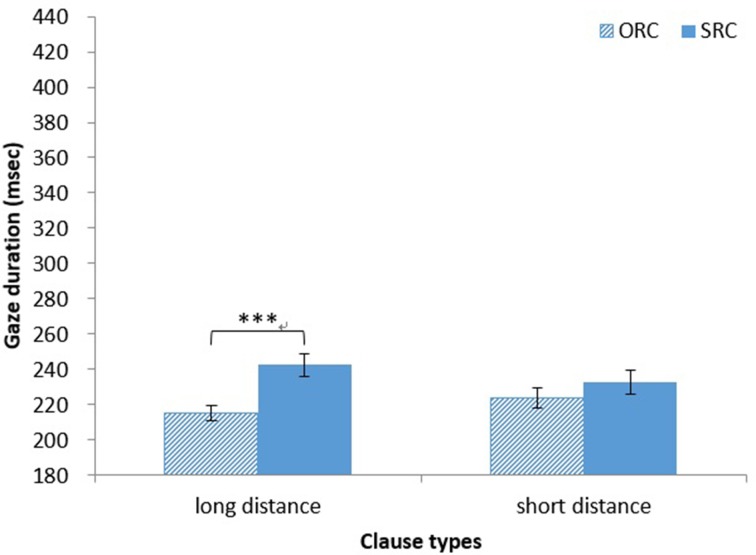
Chinese group: gaze duration for HNs in RCs. ***p < 0.001.